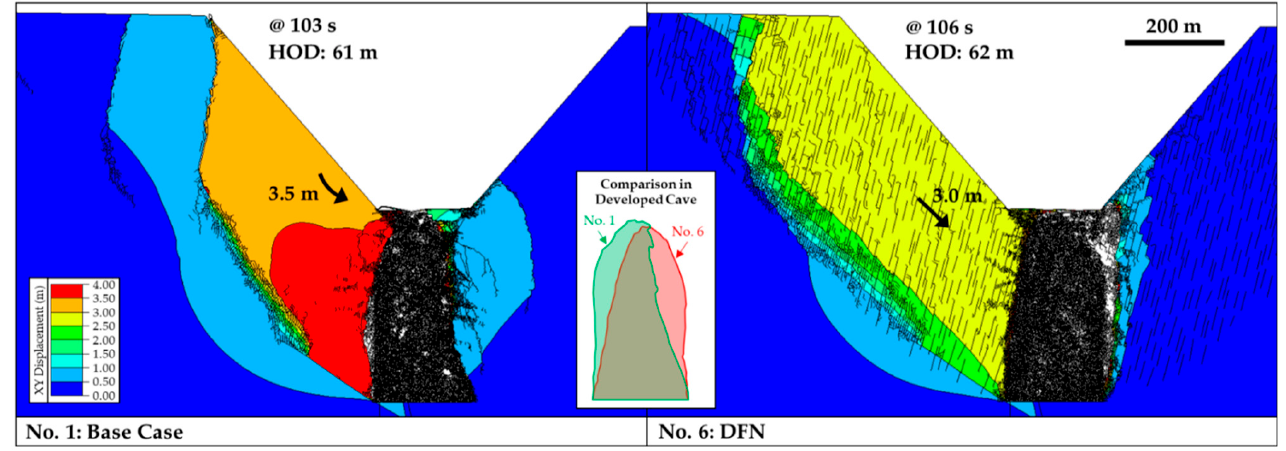
Figure 14. FDEM model results for models No. 1 and No. 6 after 8900 m 2 ± 1% material removed. Maximum XY displacement contours. Developed cave shape comparison defined by 10 m vertical displacement.